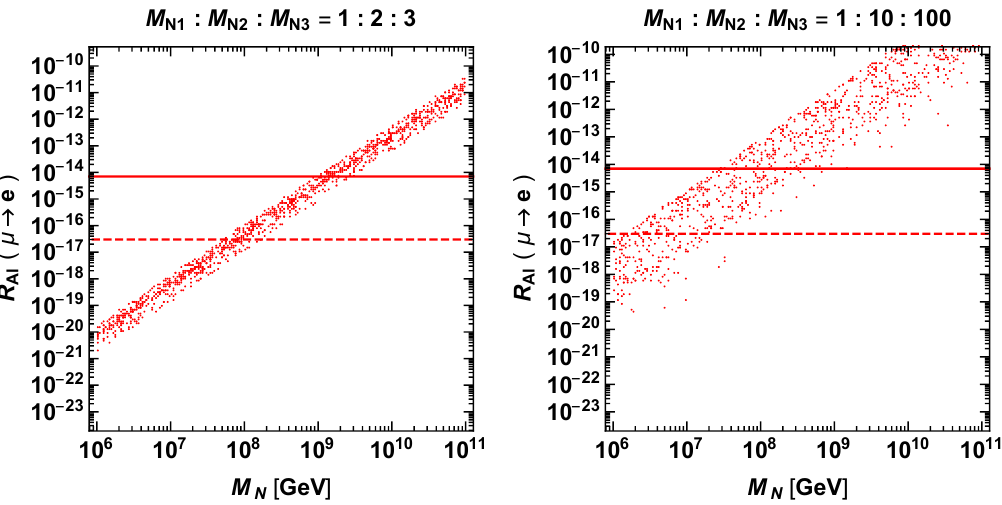
Figure 7 . BR( µ → eγ ) is shown for the model B . In the left (right) panel, M N 2 : 3 ( M N : M N : M N = 1 : 10 : 100 ) with M N = M N 1 2 3 and M 2 = 600 GeV. The other parameters are same as figure 6.